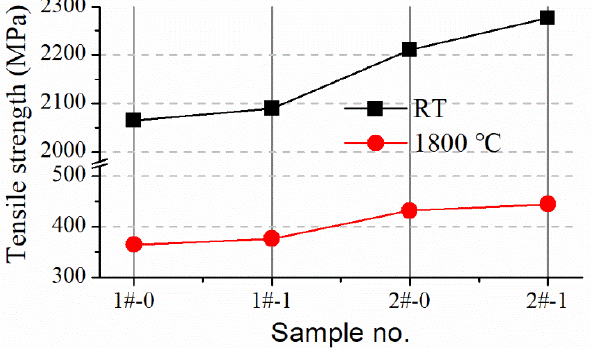
Figure 2. Tensile strengths of four samples at room temperature (RT) and 1800 °C.